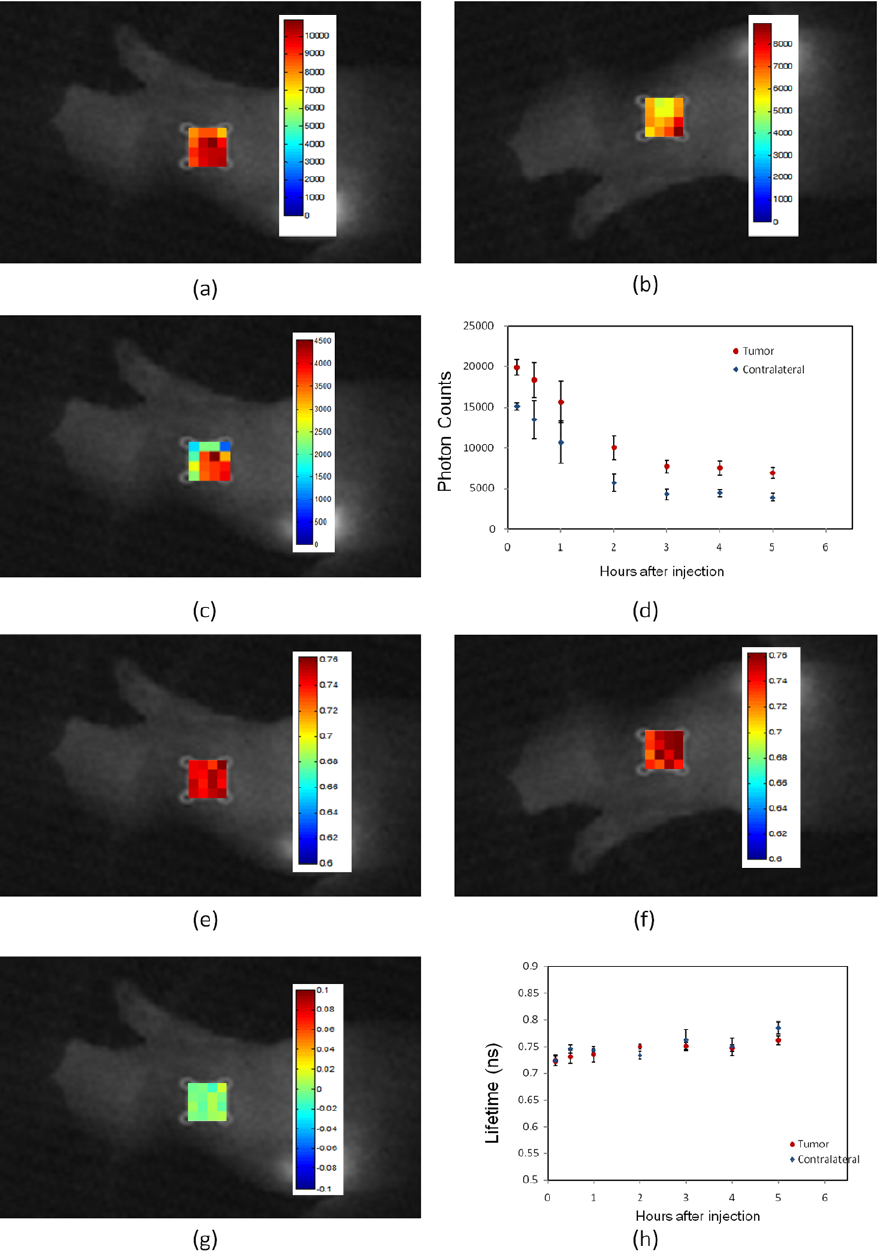
Figure 5. Invivo fluorescence imaging of xenograft mouse with no HER2 expressing human tumor model (MDA-MB-468) after injection of the HER2-specific Affibody H (His6-Z HER2 :GS-Cys) conjugated to Dylight750. ( A ) Fluorescence intensity map at the tumor region. ( B ) Fluorescence intensity map at the contralateral site. ( C ) The difference of fluorescence intensity at the tumor region and the contralateral site, mapped on the tumor region. ( D ) Pharmacokinetics of the fluorescence intensity at the tumor region and contralateral site after the injection over time. The data in Figs. ( D ) and ( H ) are the average data of three mice. Markers show the average and bars show the standard deviation. ( E ) Fluorescence lifetime map at the tumor region. ( F ) Fluorescence lifetime map at the contralateral site. ( G ) The difference of fluorescent lifetime at the tumor and the contralateral site mapped on the tumor region. ( E ) Pharmacokinetics of the fluorescent lifetime at the tumor region and contralateral site after injection over time.